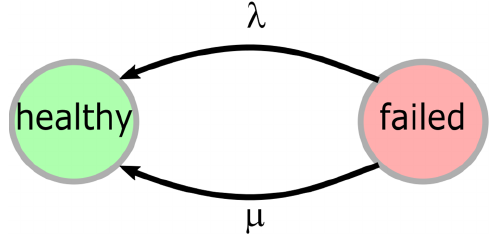
Figure 11. Markov chain of a two-state system.